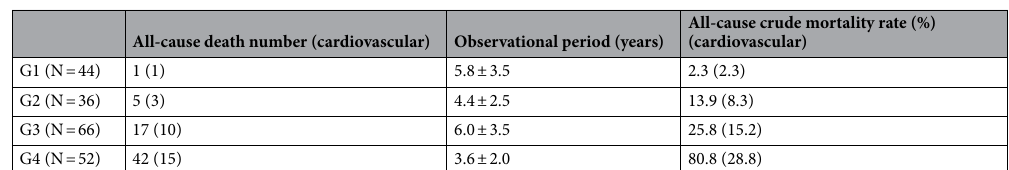
Table 3. All-cause and cardiovascular death number, observation period, and crude mortality rate in the divided four groups.